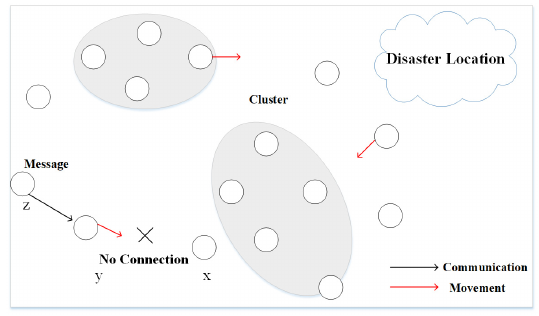
Figure 3. Disaster network topology.